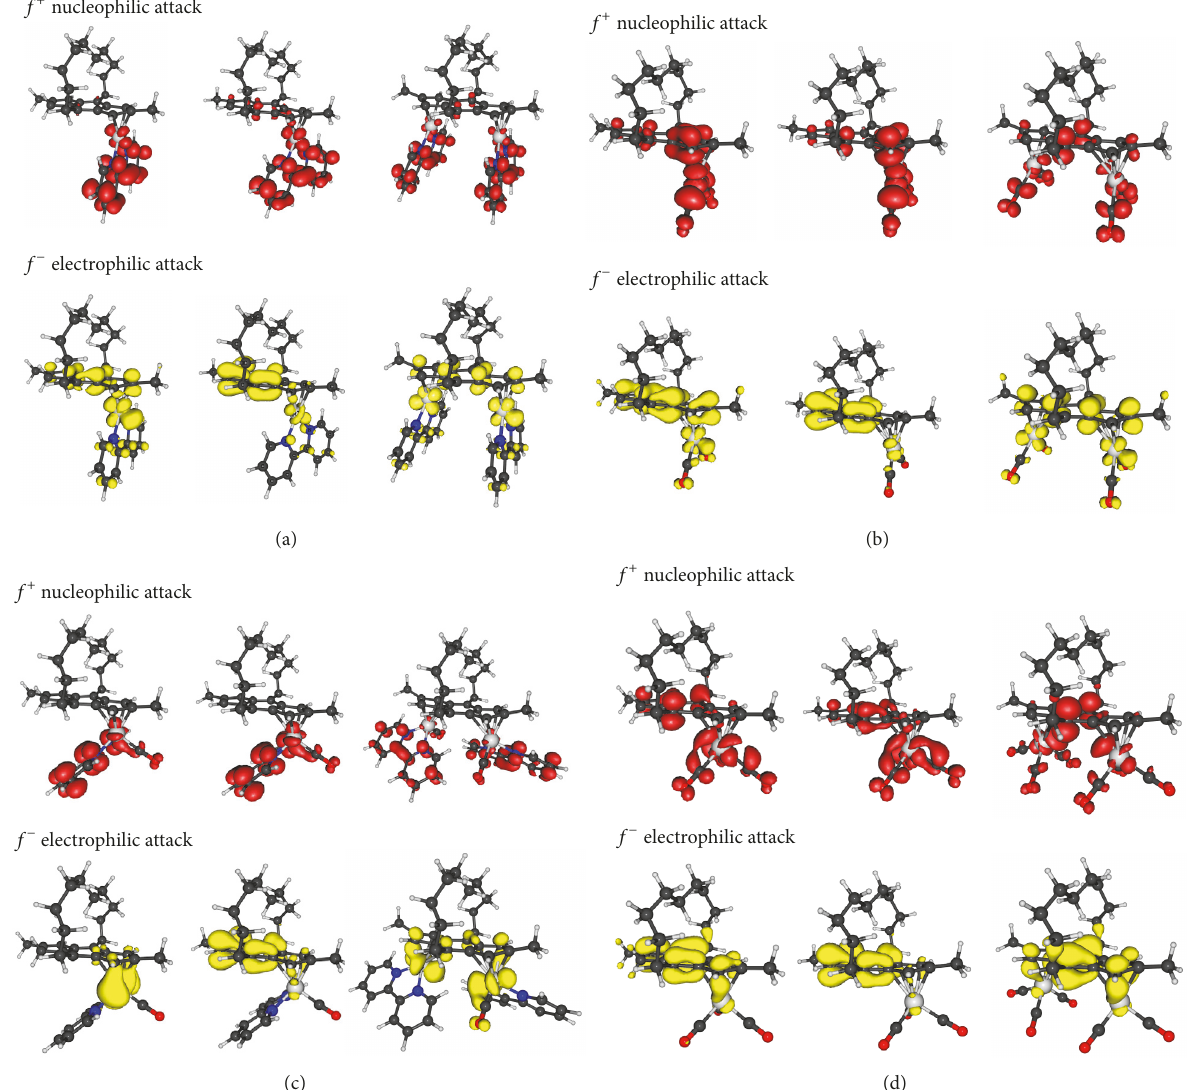
Figure 3: Condensed Fukui functions for nucleophilic ( 𝑓 + ) and electrophilic ( 𝑓 − ) attacks for compounds with metals (M) and ancillary ligands as follows: (a) Rh and bipy, (b) Rh and CO, (c) Re and bipy, CO, and (d) Re and CO. The neutral monometallic, anionic monometallic, and bimetallic complexes are